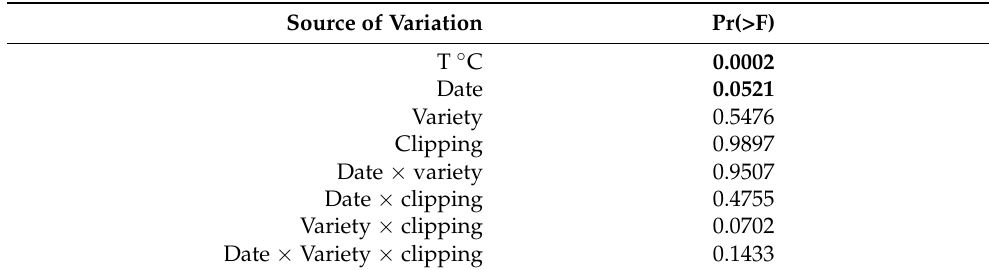
Table 2. Type III analysis of variance table with Satterthwaite’s method. Significant terms ( p -value < 0.05) are reported in bold.